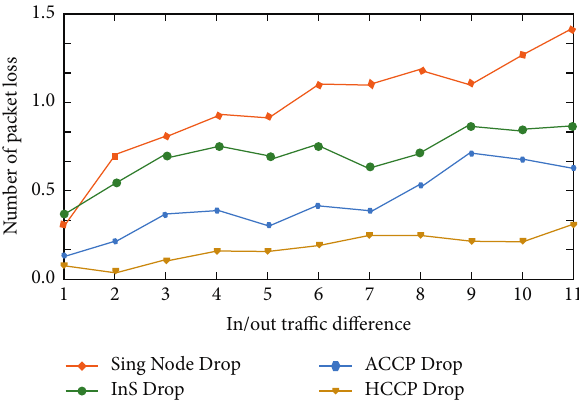
Figure 7: Average end-to-end delay.